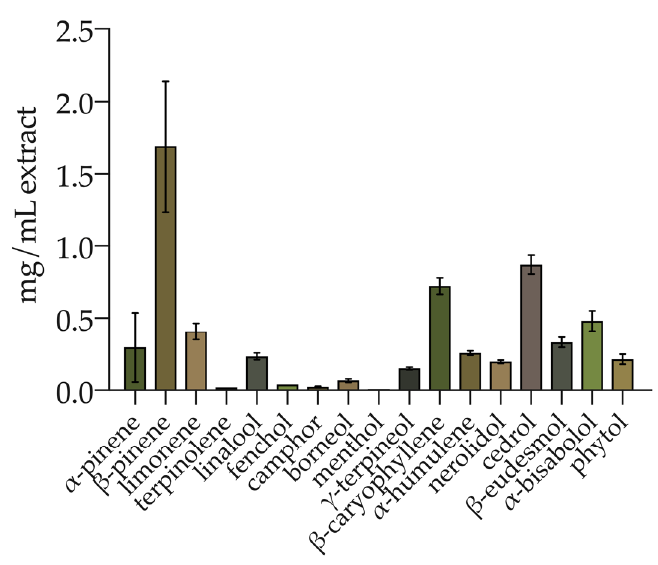
Figure 1. Terpene profile of hemp inflorescence ethanolic extract. Values are reported as the mean ± standard deviation ( n = 3).